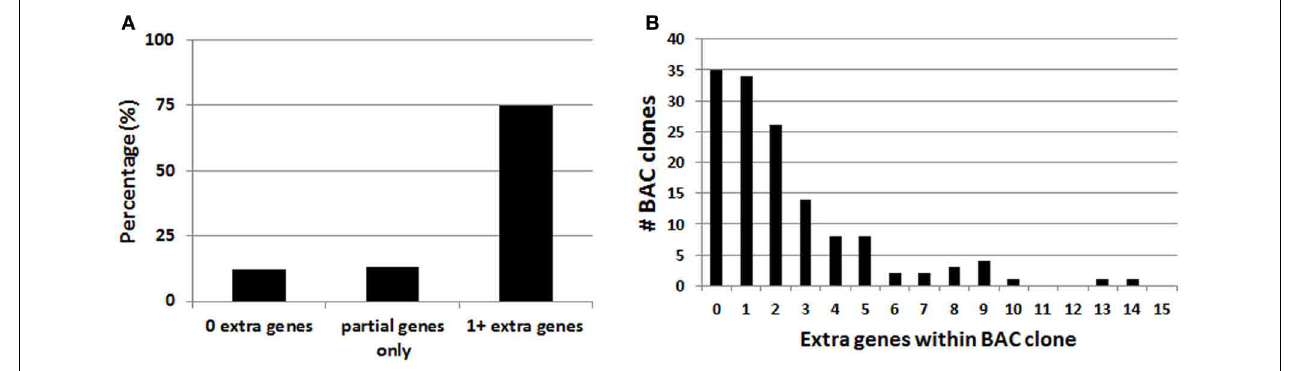
FIGURE 2 | Analysis of extra genes spanned by BAC clones of the GENSAT Cre driver repository. (A) Plot of the percentage of BAC clones with either zero, partial gene fragments only, or 1 or more extra genes